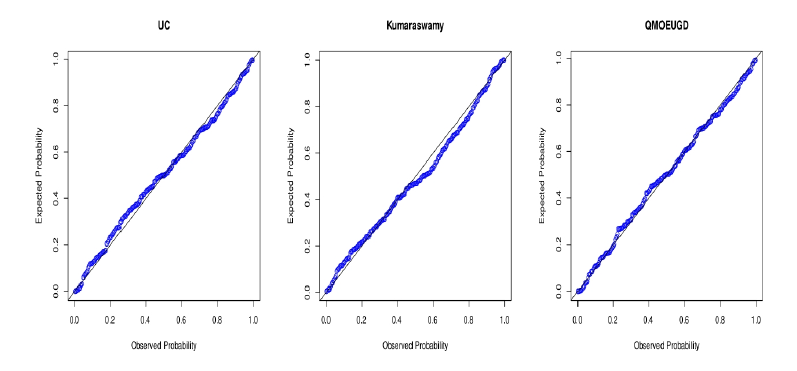
Figure 5 – PP plots of randomized quantile residuals for the fitted regression